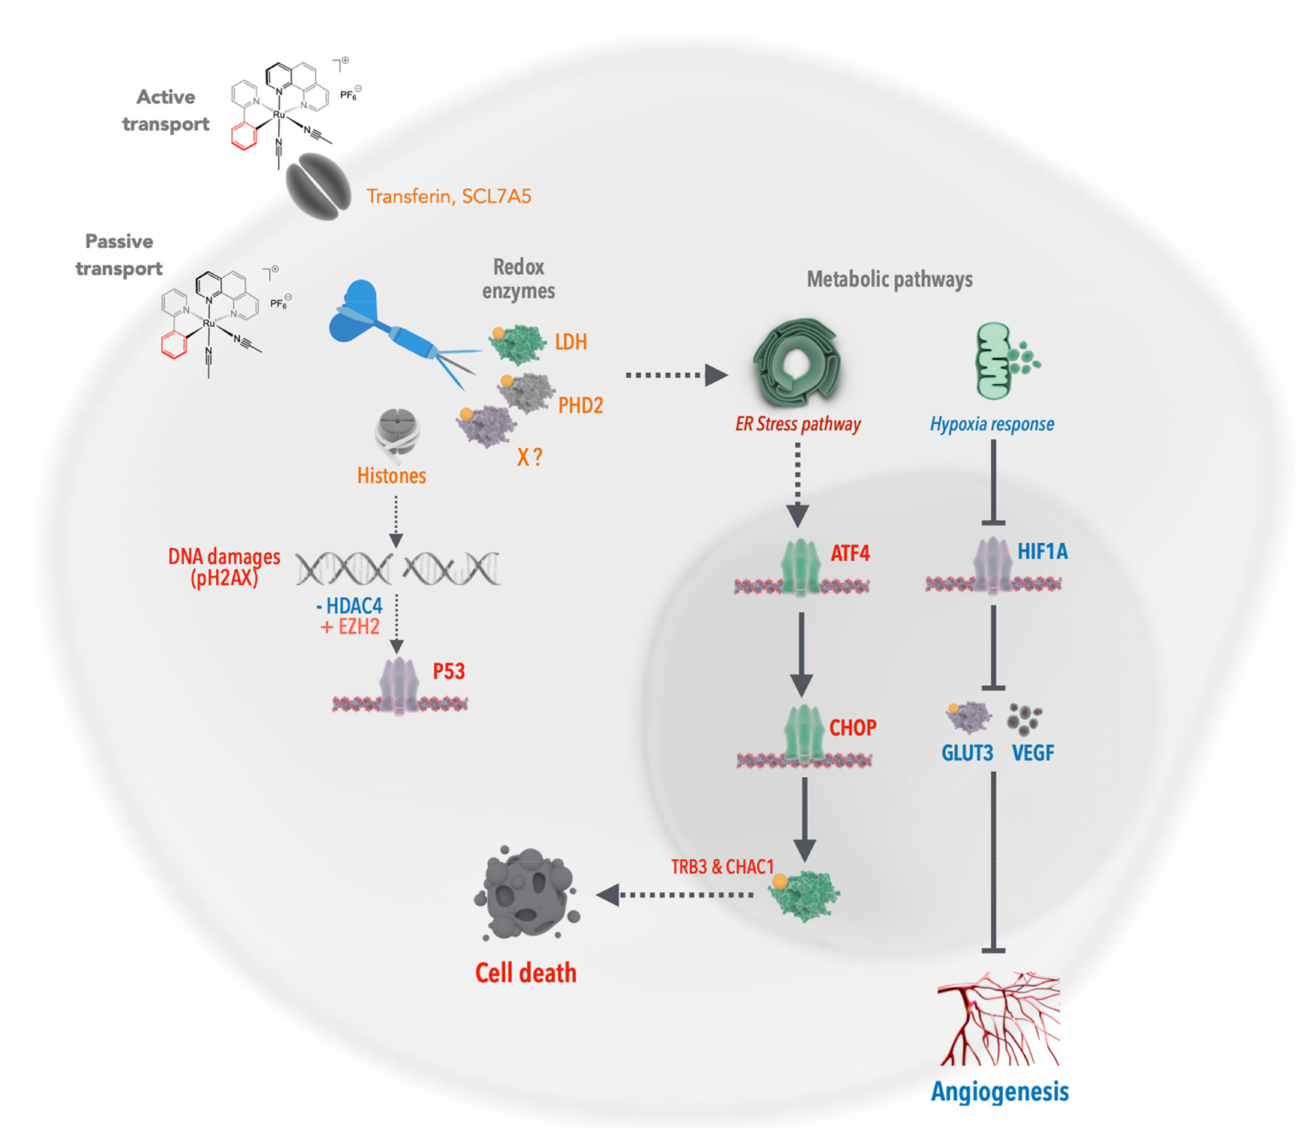
Figure 10. Up-to-date knowledge on the mode of action of ruthenium and osmium complexes. If ruthenium complexes can inhibit the activity of redox enzymes, the reverse is also true. Dr. A. D. Ryabov and Dr. R. Le Lagadec had previously showed that depending on the oxidation state, the ruthenium complexes may have opposite effects on the enzyme, glucose oxidase depending [48,49]. We recently extended that observation showing that RDC11 can favor the activity of the iron redox enzyme PHD2 (prolyl hydroxylase domain-containing protein 2) and that this has a profound impact on the biological activity of RDC11 as an anticancer agent. We identified PHD2 as a possible target through a transcriptomic